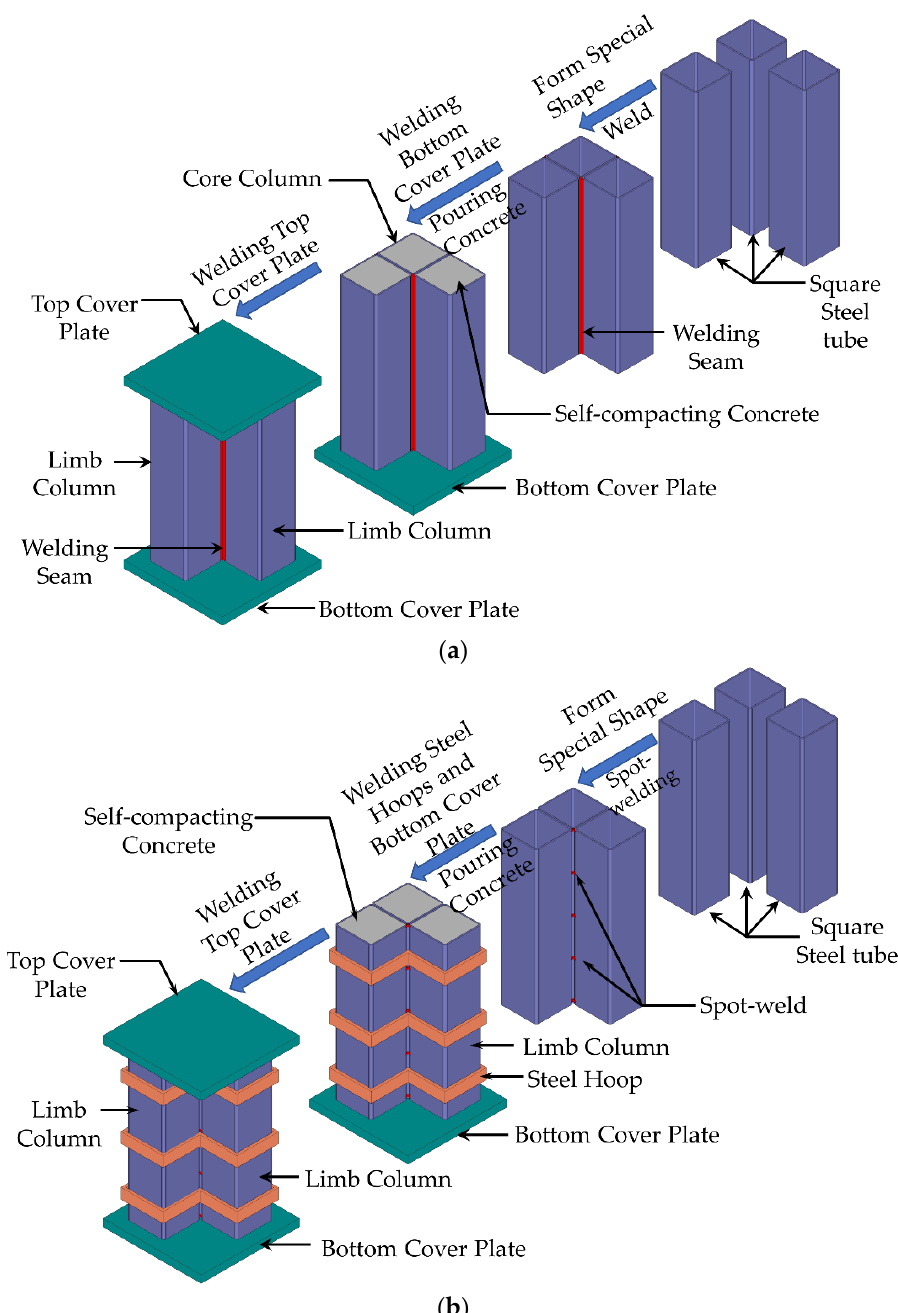
Figure 3. Schematic diagrams of the specimens manufacturing process with L-shaped sections ( a ) weld-type; ( b ) hoop-type.